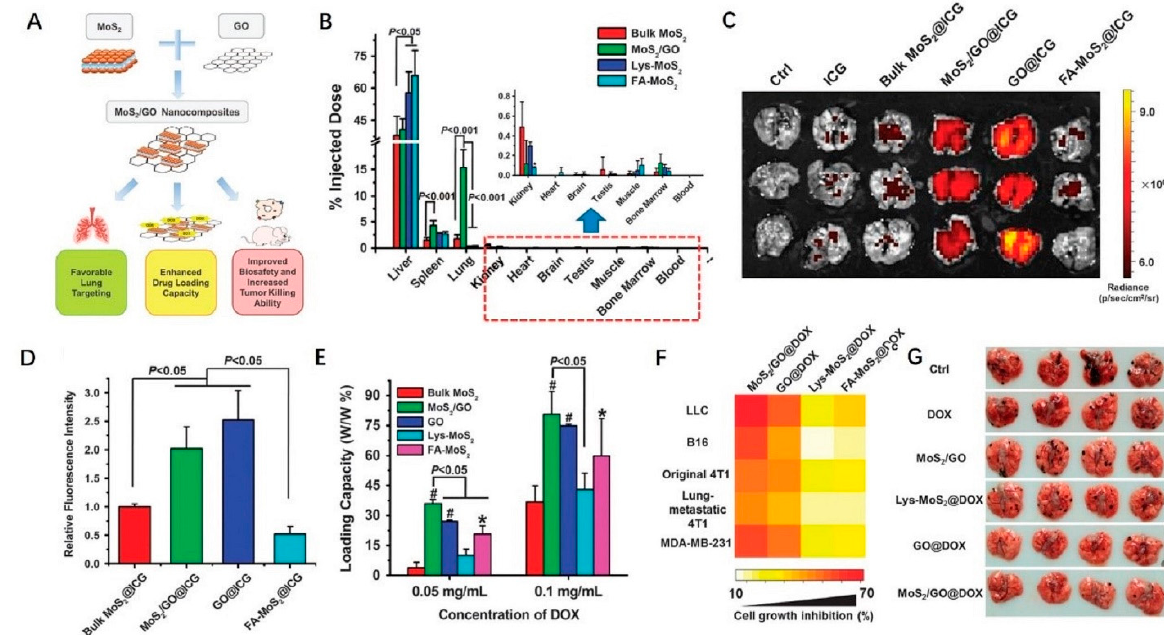
Figure 3. MoS 2 /GO nanocomposites. ( A ) The overall schematic diagram depicting functionality and biocompatibility enhancement through the synthesizing of MoS 2 /GO nanocomposites; ( B ) in vivo biodistribution of various materials in mice. The Mo contents were examined in mice 24 h post i.v. injection. The results from ICP-MS determination were shown as % of injected. In vivo imaging and lung accumulation analysis; ( C ) ICG fluorescent images of lungs from mice 24 h post-injection of free ICG and ICG-loaded nanomaterials; ( D ) quantification of relative ICG fluorescence in lungs ( n = 3). ICG, indocyanine green. DOX loading capacity and tumor killing efficacy of different materials; ( E ) DOX loading capacity of nanomaterials ( n = 4). * indicates p < 0.05 and # denotes p < 0.001, com- pared to bulk MoS 2 -treated group; ( F ) in vitro tumor killing efficacy of DOX-loaded materials at the same mass concentrations ( n = 5). The concentrations of materials were tailored for each type of cells as follows: 2 μ g·mL − 1 for LLC cells, 6 μ g·mL − 1 for B16 cells, 30 μ g·mL − 1 for 4T1 cells, and 15 μ g·mL − 1 for MDA-MB-231 cells; ( G ) representative images of metastatic tumor nodules in the lungs from treated and untreated mice with implantation of B16 murine melanoma cancer cells. DOX, doxoru- bicin; LLC, Lewis lung carcinoma. Reproduced with permission from ref. [89]. Copyright (2018). Springer Nature.